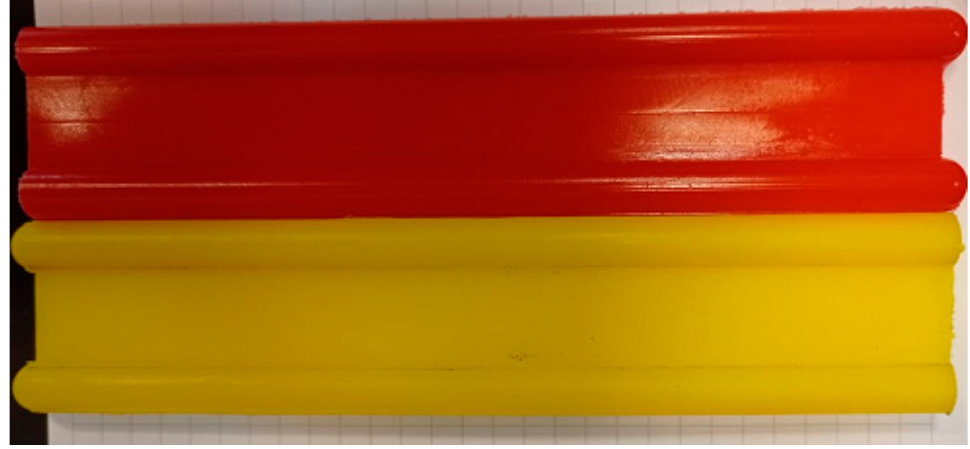
Figure 1. PS (pure shear) specimen geometry (width W = 140 mm, thickness t = 2 mm, effective height h = 15 mm) for relaxation test .